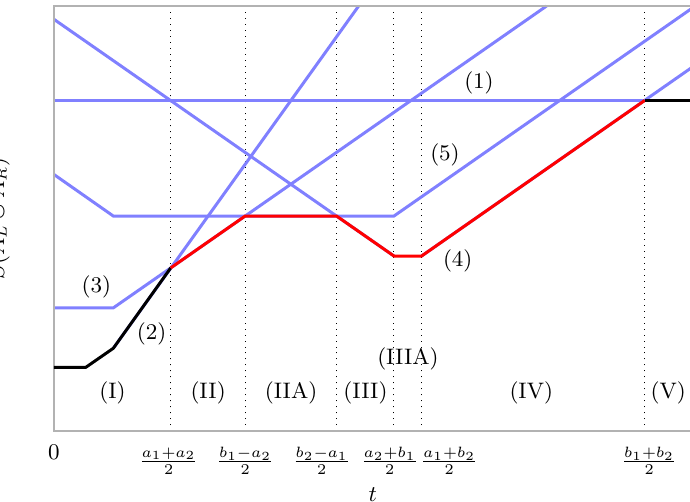
Figure 10 . Plot of the entropy in the high temperature limit with non-symmetric intervals A L = [2 , 12 . 5] and A R = [3 . 5 , 15 . 3] . As in previous plots, channels are shown in blue and labelled with a number (1) , etc. The red portion corresponds to the island saddle for the black